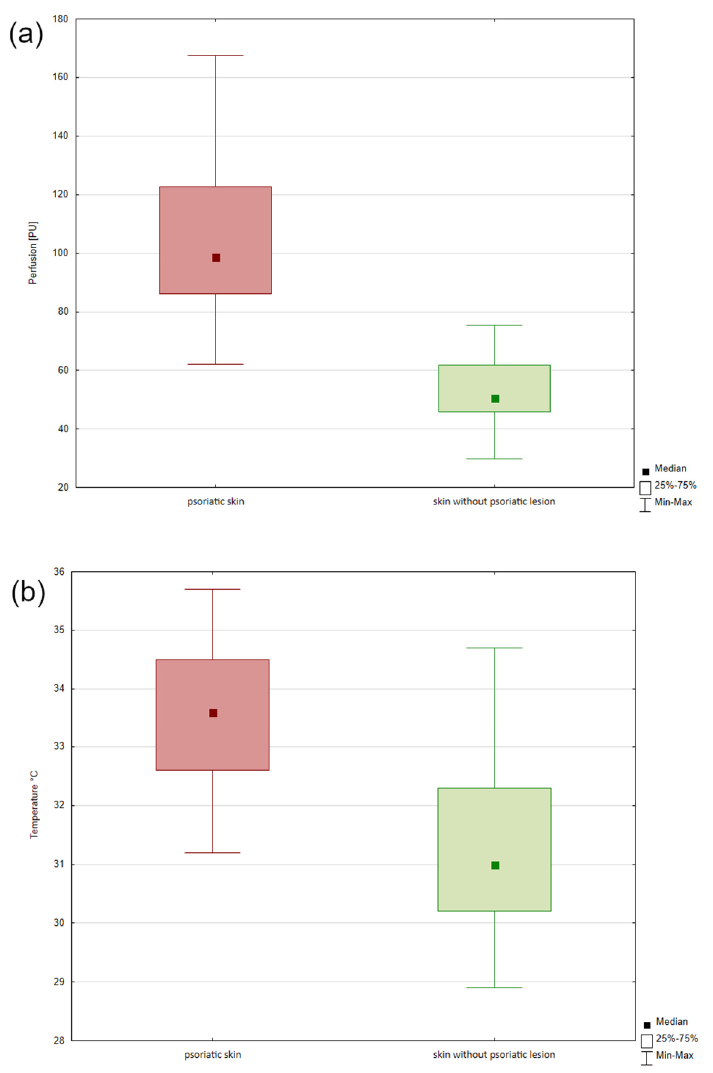
Figure 6. The LASCA results of the blood perfusion of the psoriatic skin and skin without psoriatic lesion ( a ). The result of the measured skin temperature of psoriatic skin and skin without psoriatic lesion ( b ).